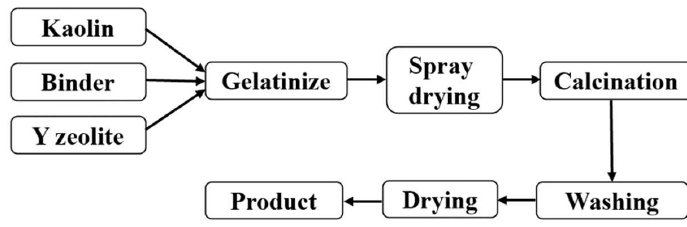
Figure 1. Preparation process of the semisynthetic FCC catalyst. Kaolin (dry base, wt.%): Pseudo-boehmite (dry base, wt.%): Aluminum Sol (Al 2 O 3 content, wt.%): Y molecular sieve (dry group, wt.%) =